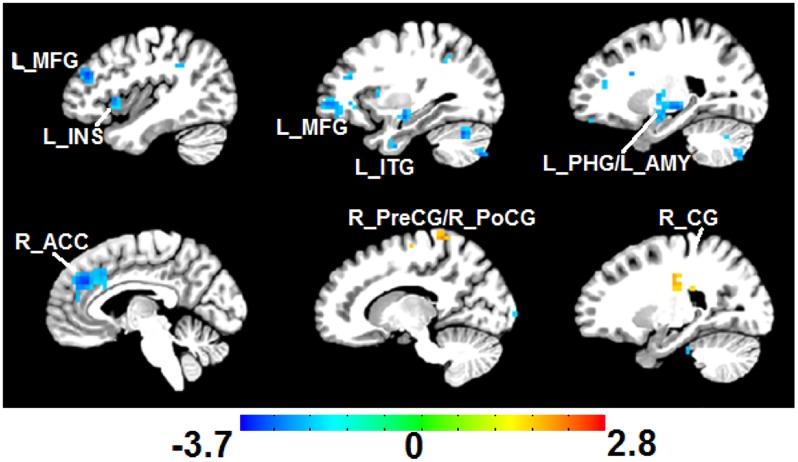
Altered PAG FC in FBSS.PAG FC was significantly decreased (cold color) in L_MFG, L_INS, L_ITG, L_PHG, L_AMY, and R_ACC. FC was increased (warm color) between PAG and the R_PreCG, R_PoCG, and R_CG when compared with the CN group (p<0.05, AlphaSim correction). The color bar represents the corresponding Z scores. Legend: Periaqueductal gray (PAG), Left middle frontal gyrus (L_MFG), left insula (L_INS), left inferior temporal gyrus (L_ITG), left parahippocampal gyrus (L_PHG), left amygdala (L_AMY), right anterior cingulate cortex (R_ACC), right precentral gyrus (R_PreCG), right post central gyrus (R_PoCG), right cingulate gyrus (R_CG).